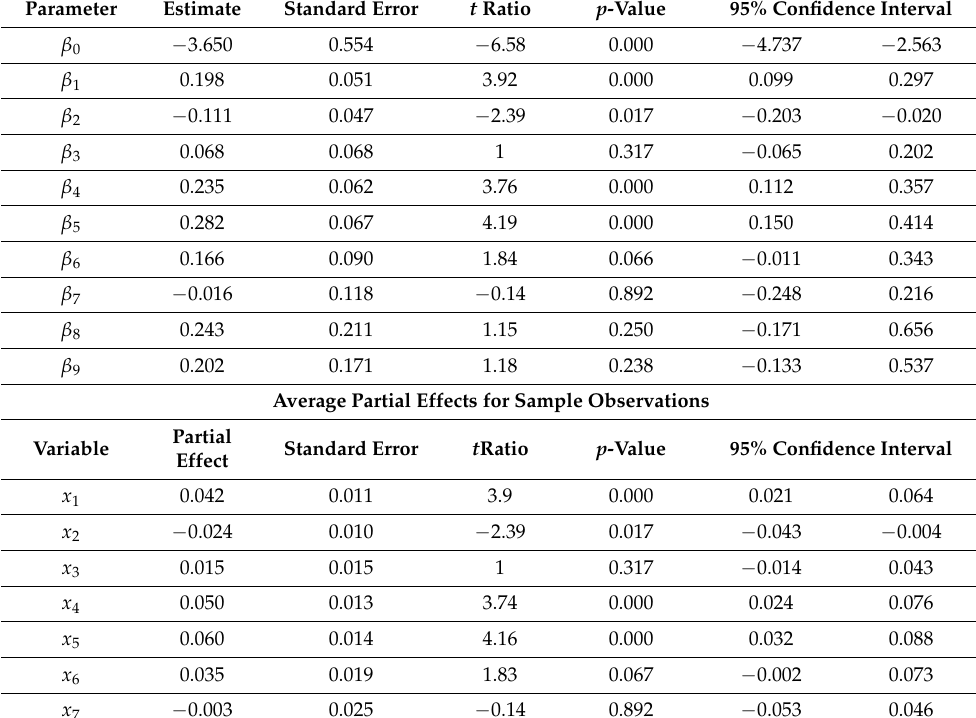
Table 2. Logistic regression, results